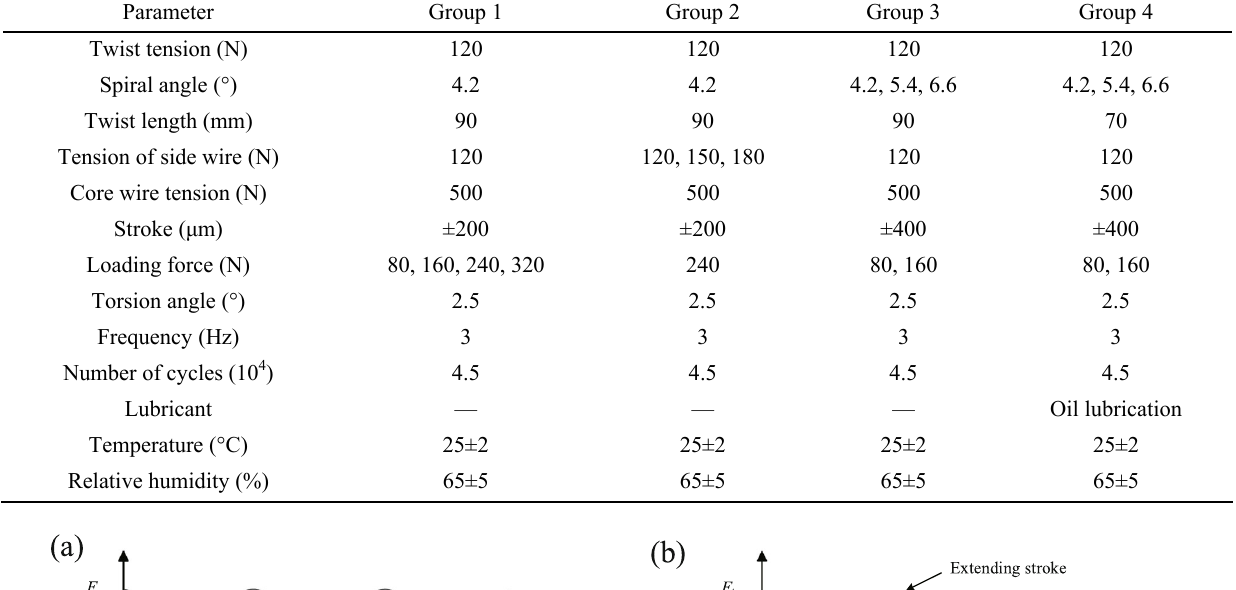
Table 4 Fretting friction and wear test conditions.